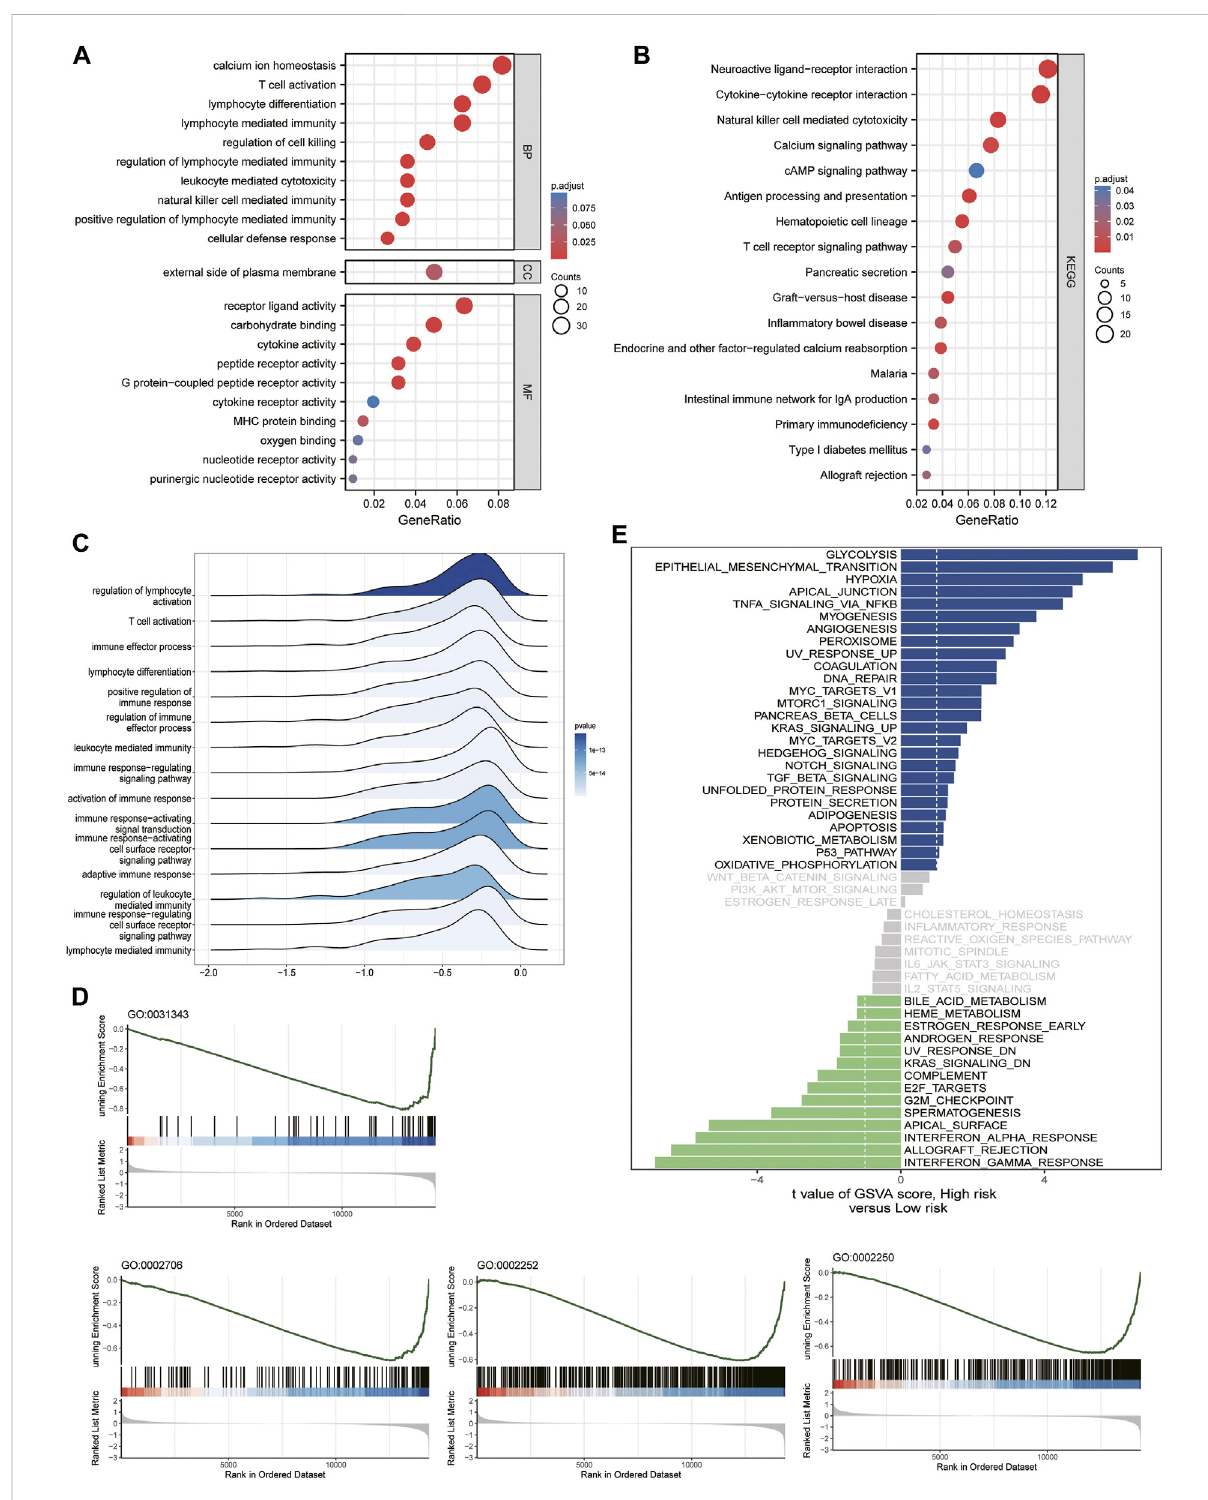
FIGURE 6 Functional enrichment analysis with GSE41613 cohort risk score grouping. (A) GO signaling pathway analysis. (B) KEGG signaling pathway analysis. (C) Ridge plot. (D,E) GSEA enrichment analysis and GSVA enrichment